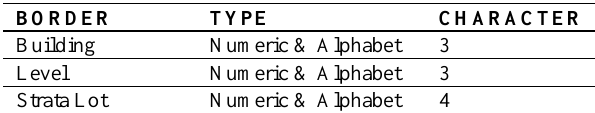
Table 2. UFI criteria